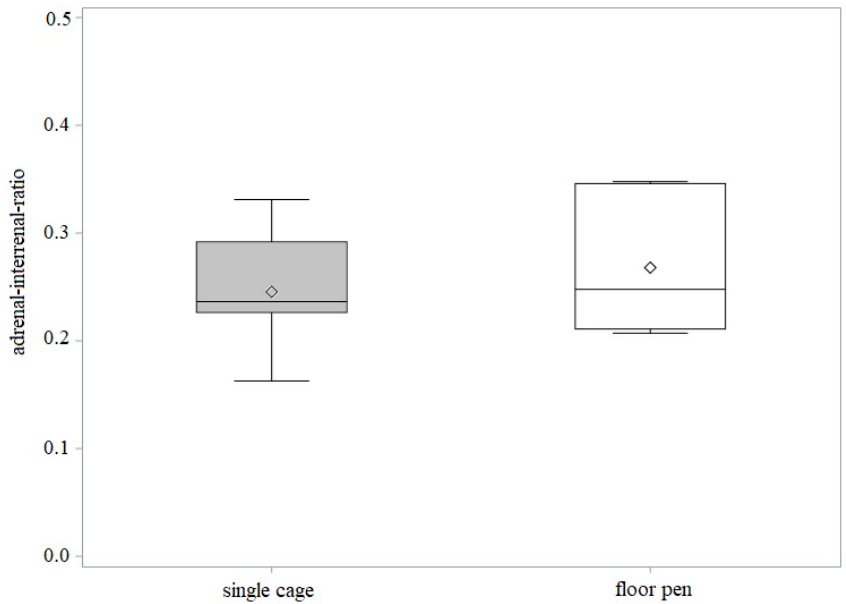
Figure4. Adrenal–interrenal ratio in single cages ( n = 7 laying hens, grey box) and in floor pen ( n = 6 laying hens, white box). The vertical boxes show the range between the 25th and 75th percentiles with whiskers extending to 2.5 of the interquartile range. The horizontal line indicates the median; diamond indicates the mean.